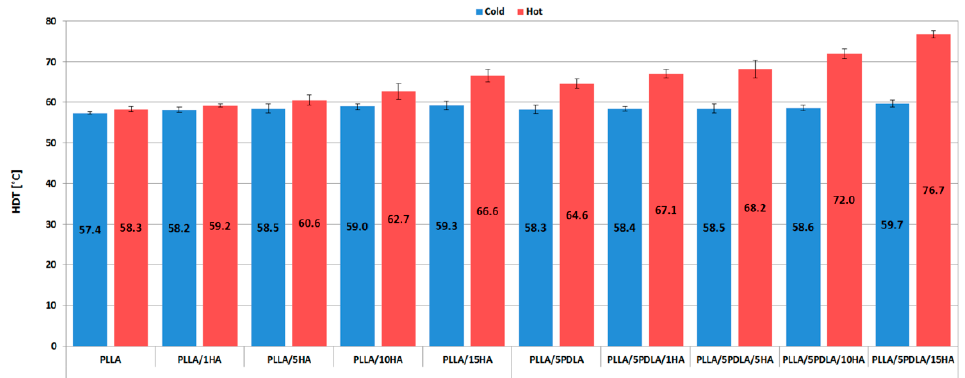
Figure 7. Heat deflection temperature plots of samples from cold and hot molds.